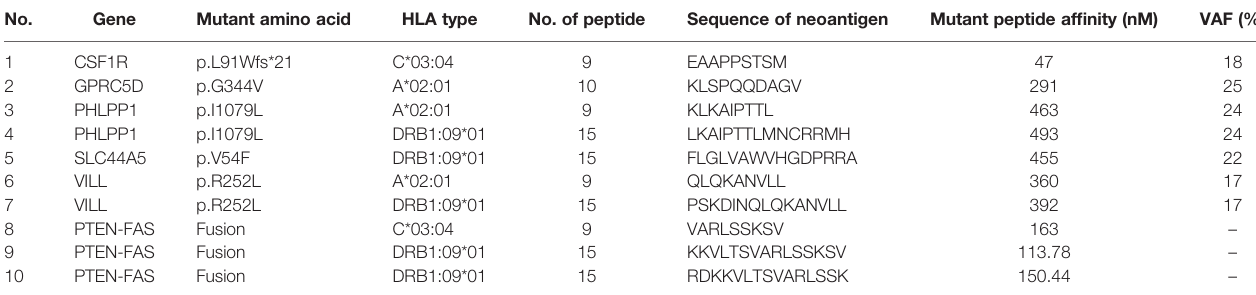
TABLE 1 | Personalized neo-epitope vaccine peptides and predicted HLA binding.